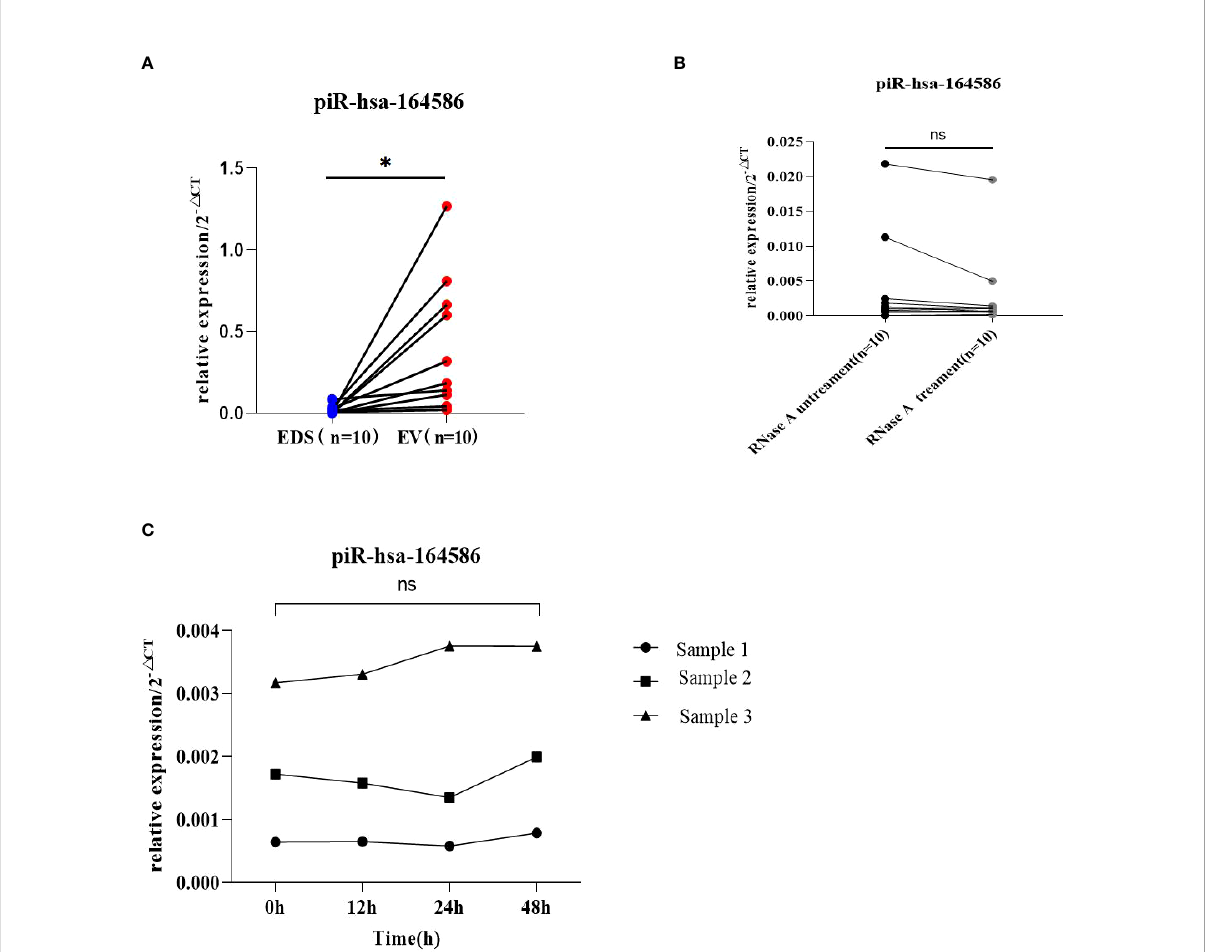
FIGURE 3 Evaluation of the stability of piR-164586 of extracellular vesicle in serum samples (A) Expression level of piR-hsa-164586 in extracellular vesicles (EV) and extracellular vesicles depleted suspension (EDS); (B) qRT-PCR analysis of the expression level of piR-hsa-164586 in extracellular vesicles with or without RNase A treatment; (C) Expression level of piR-hsa-164586 of extracellular vesicles stored at room temperature for different times (0h, 12h, 24h and 48h) (ns, no signi fi cance; *p ≤